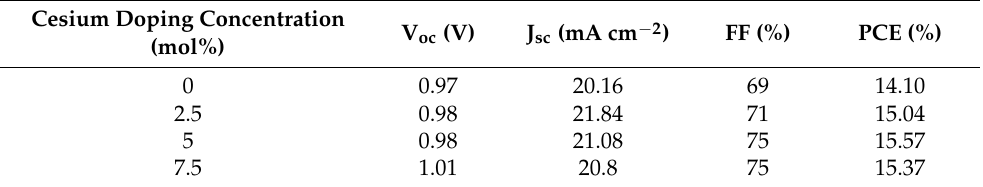
Table 1. Average photovoltaic parameters of the MAPbI 3 PSCs based on perovskite precursors with